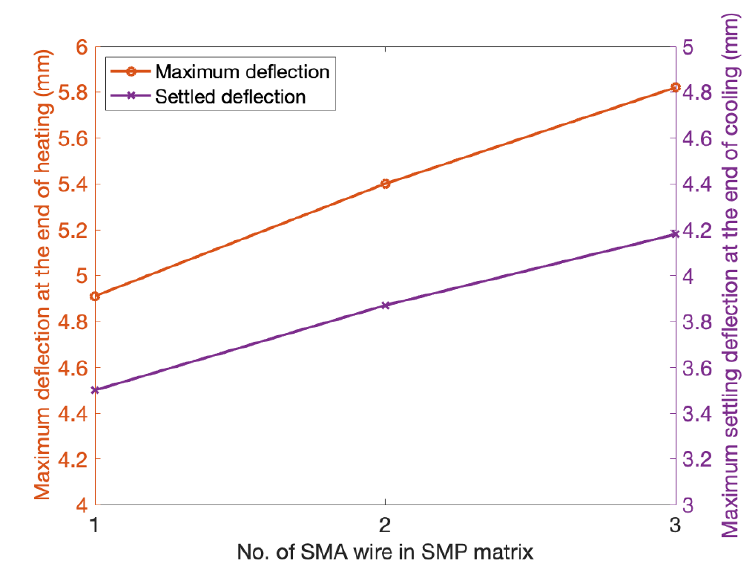
Figure 12. Effect of increasing the volume ratio of the SMA wires in the matrix on the maximum and settled deflection of the SMC at the end of one cycle of actuation (from the COMSOL